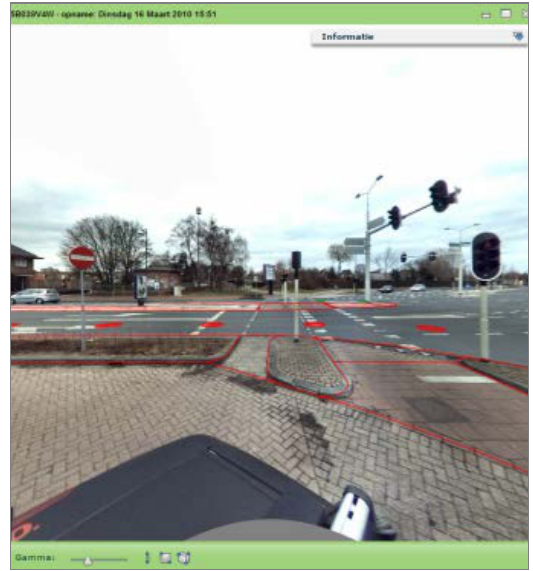
Figure 10. 2D map data overlaid on plain Cyclorama